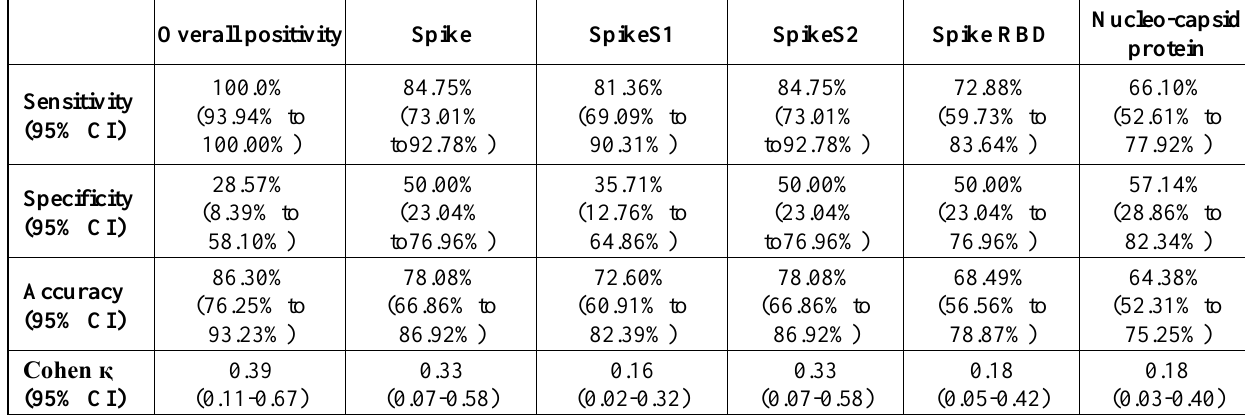
Table 4. Performance of SARSCoV-2 by LABScreen COVID Plus Assay in comparison with NAAT as the gold